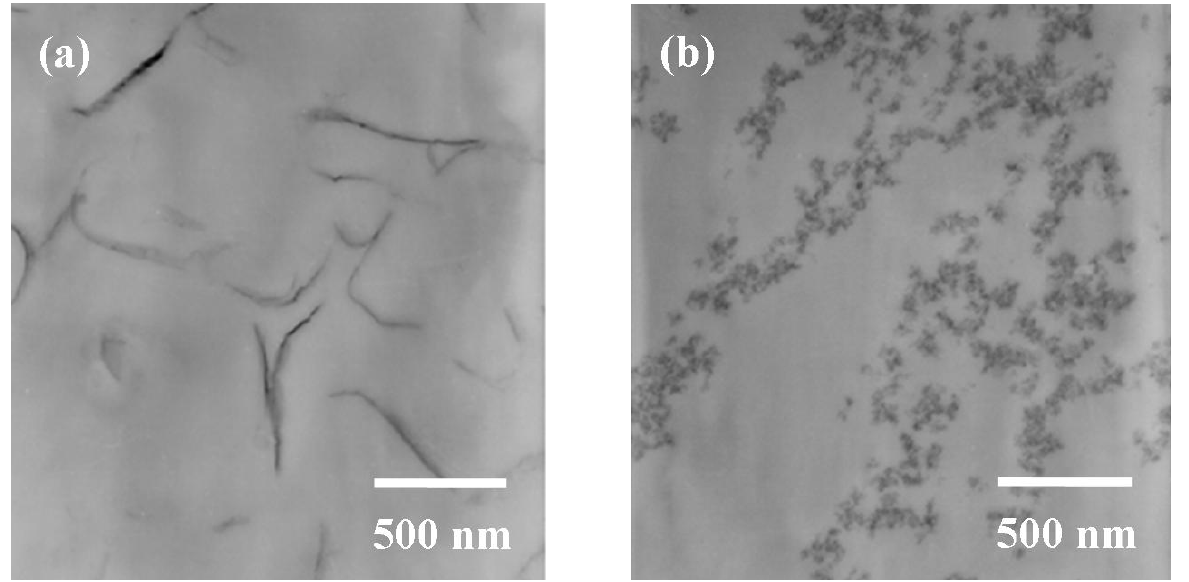
Figure 5. TEM of cured epoxies containing 3 wt % of (a) silicate platelets (b) silicate oxide particles (reprinted with permission from reference [78]).